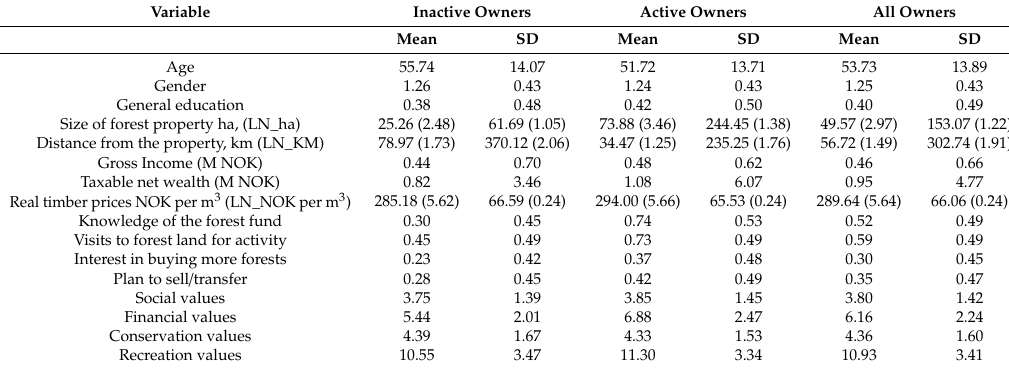
Table 2. Descriptive statistics (mean values and standard deviations) of the independent variables tested to a ff ect NIPF owners’ decision to harvest timber (owners grouped as Active and Inactive based on harvesting activity from the last 15 years). Weighted numbers. SD = standard deviation. See Table 1 for variable